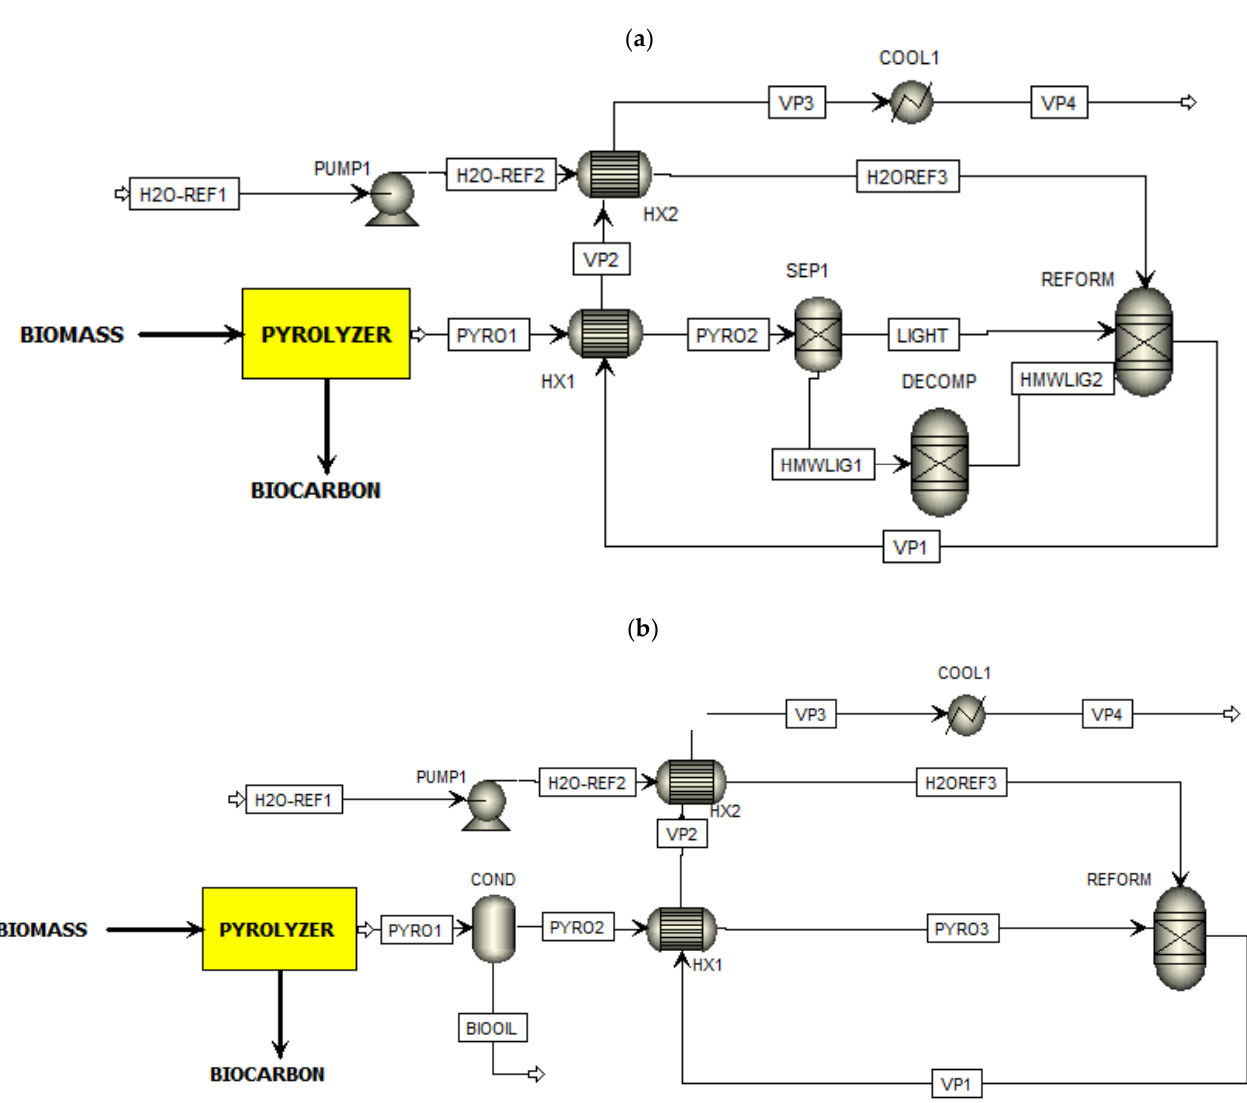
Figure 4. Flowsheet diagram of the steam reforming process in ( a ) Scheme 1 and ( b ) Scheme